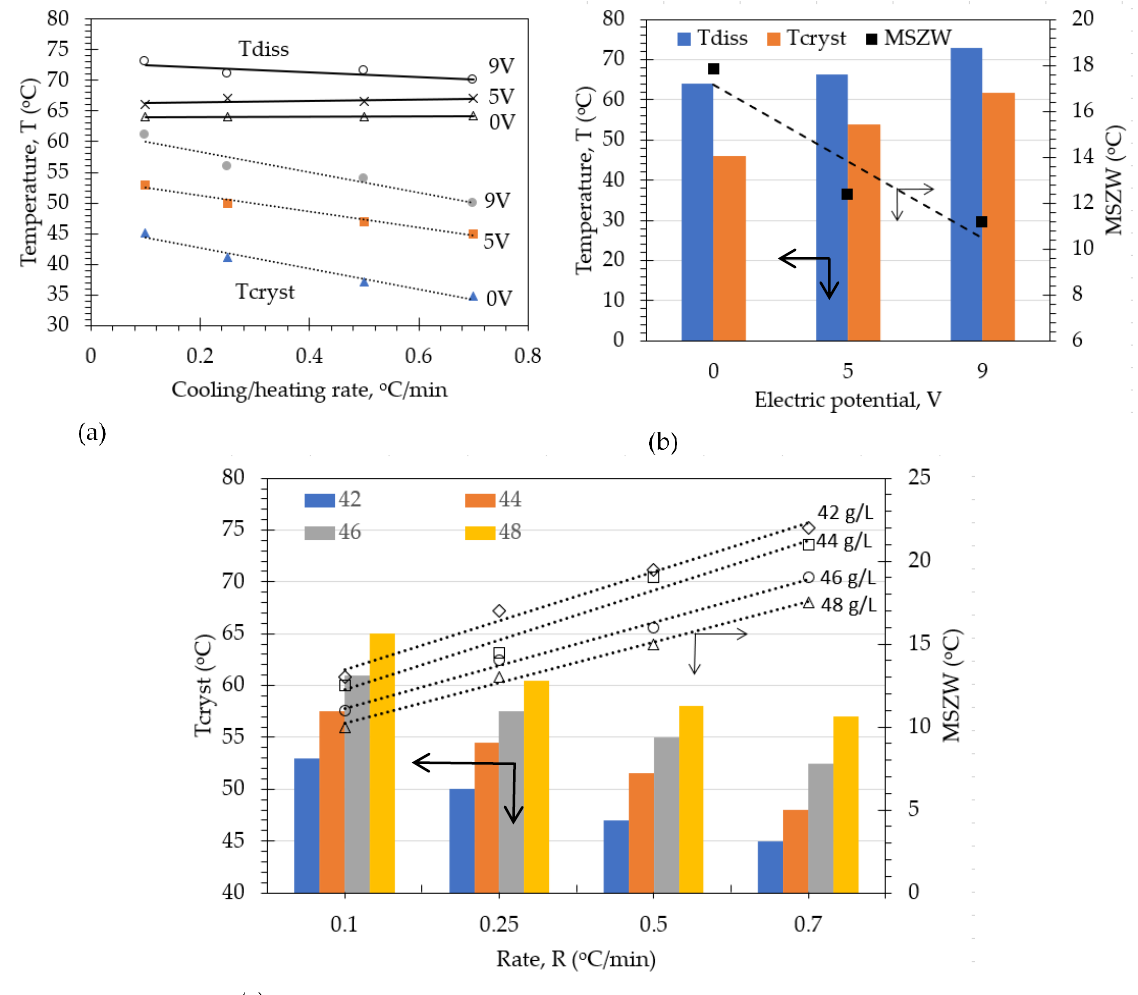
Figure 3. ( a ) Temperature of dissolution, Tdiss (shown by the solid line), and temperature of crystallisation, Tcryst (shown by the dashed line), for a solution concentration of 42 g/L with the presence of various electric potentials. Data for 0 V were extracted and recalculated from the data presented by Azmi et al. [39], ( b ) Tdiss, Tcryst, and metastable zone width (MSZW = Tdiss − Tcryst) of L-isoleucine extracted at an infinitesimally slow rate (R ≈ 0 o C/min) from the intercepts at the y -axis of Figure 4a, representing data at equilibrium. ( c ) Relationship between the Tcryst, solution concentration and MSZW when a 5 V electric potential was applied to the solution.